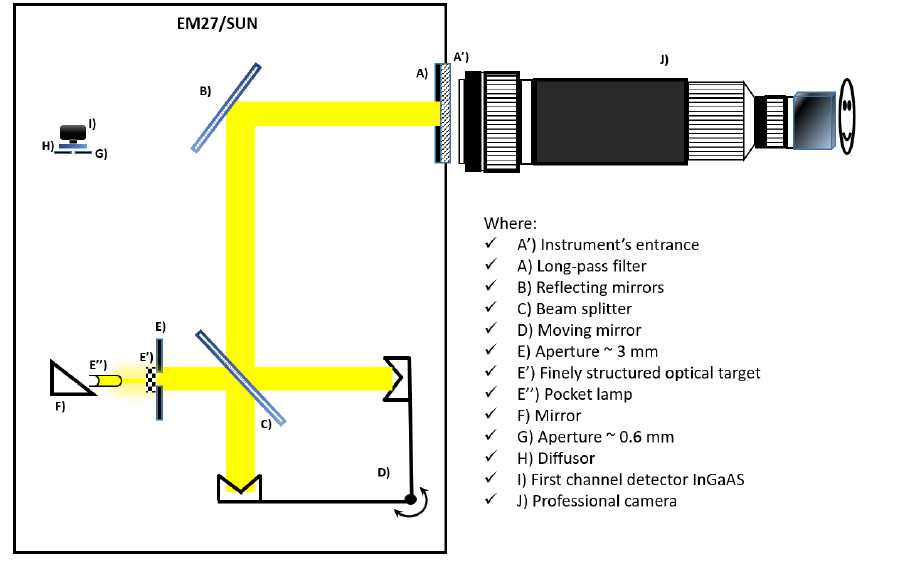
Figure 3. Light path of the beam inside the instrument coming from the lamp in E” to the camera at the instrument’s entrance